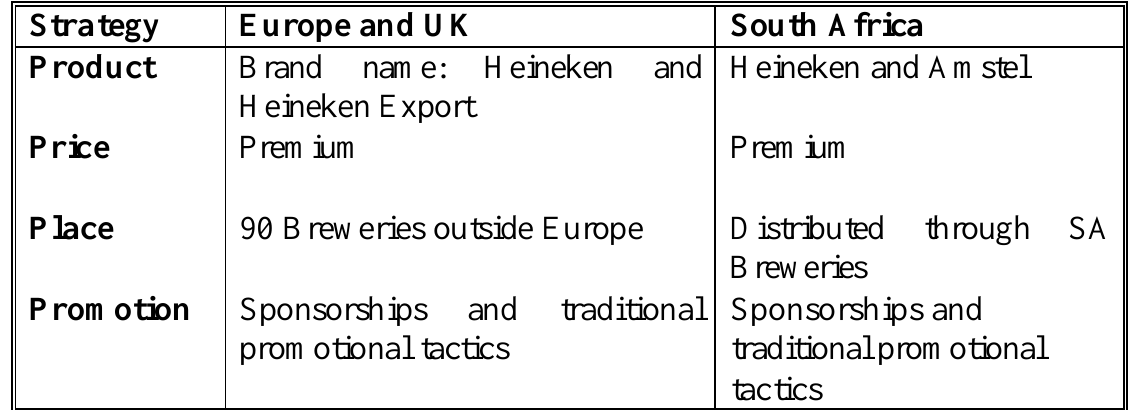
Heineken’s marketing strategy: A comparison between Europe and South